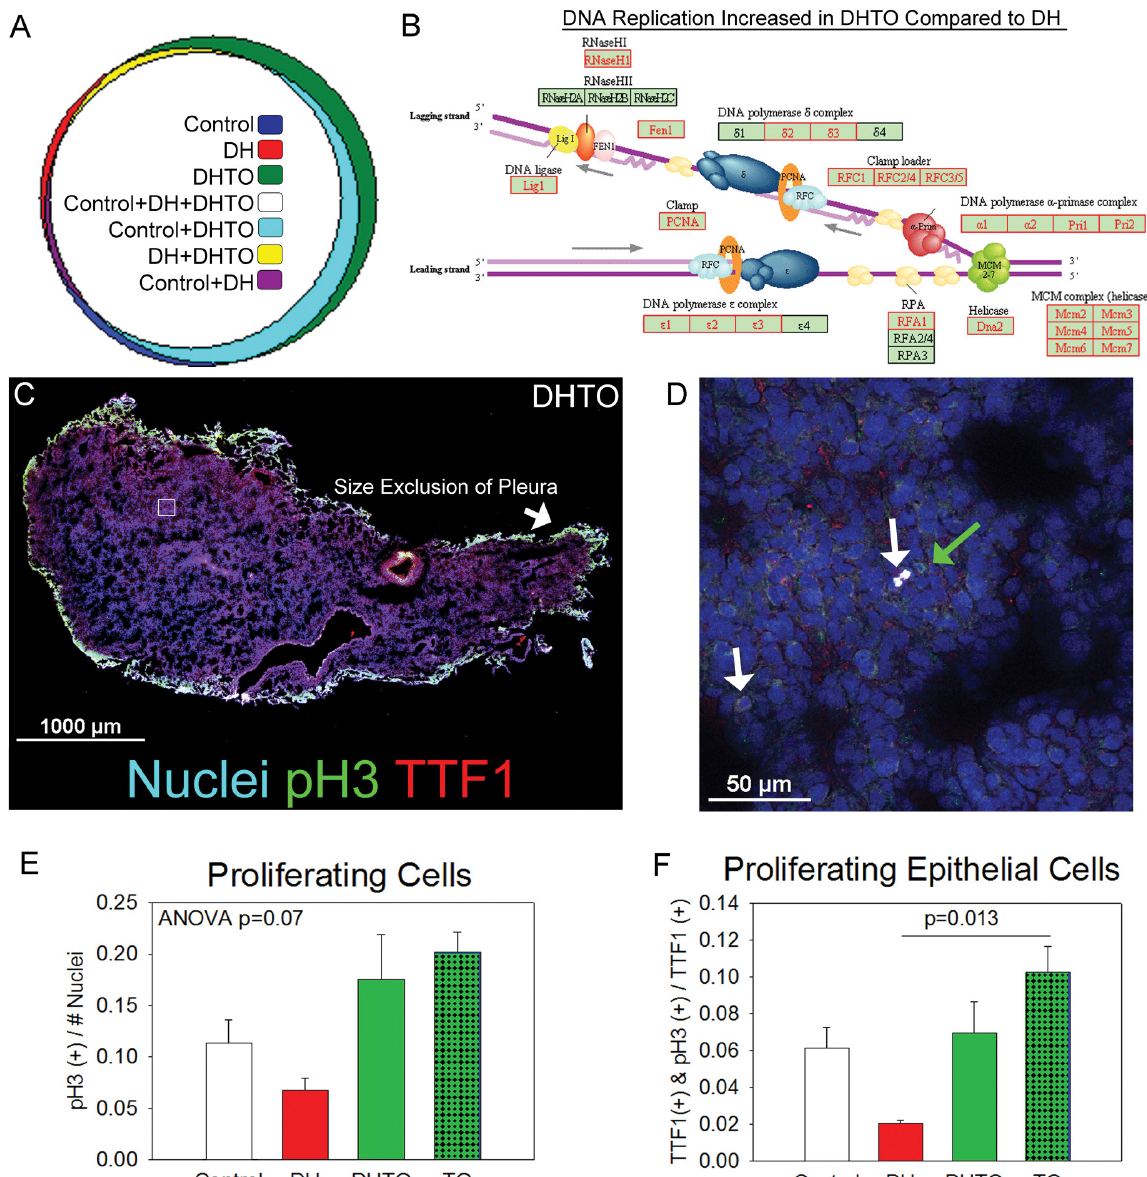
Figure 6. TO after DH increases DNA replication and cell division. (A) Among the 13,687 profiled genes, very few were uniquely expressed in control, DH, DH + control, or DH + DHTO. The majority of unique genes were expressed in DHTO (397) with a similar number in DHTO + Control (369). A proportionate Venn diagram was created using a web app from the Massachusetts Institute of Technology (31). (B) The only processes upregulated in DHTO compared with DH were DNA replication and elongation. Superimposing this gene expression profile onto the KEGG pathway for DNA replication demonstrate that expression of each component of the DNA replication complex is increased in DHTO (32,33). Red lettering indicates genes with increased expression levels. (C) Control, DH, DHTO and TO lung sections (n = 6–12) stained for the cell proliferation marker phospho-histone 3 (pH3, green) and thyroid transcription factor 1 (TTF1, Nkx-2.1, red) were imaged by tile scan and nuclear (blue) co-localization of pH3 and TTF1 quantified. The autofluorescent pleural surface was ex- cluded by object size filtering. (D) Confocal imaging of a region of the prior image demonstrated nuclei expressing both markers (white arrows) and only pH3 (green arrow). In this representative image only strongly positive cells are highlighted. (E) Quantification of total number of pH3-positive nuclei demonstrated a 2-fold reduction in DH compared with control and a 3-fold increase in DHTO and TO com- pared with DH. (F) Limiting analysis to TTF1-positive cells, there was a 3-fold reduction in pH3-positive epithelial cells in DH compared with control with a 3.4-fold increase in DHTO compared with DH and an additional 47% increase in TO compared with